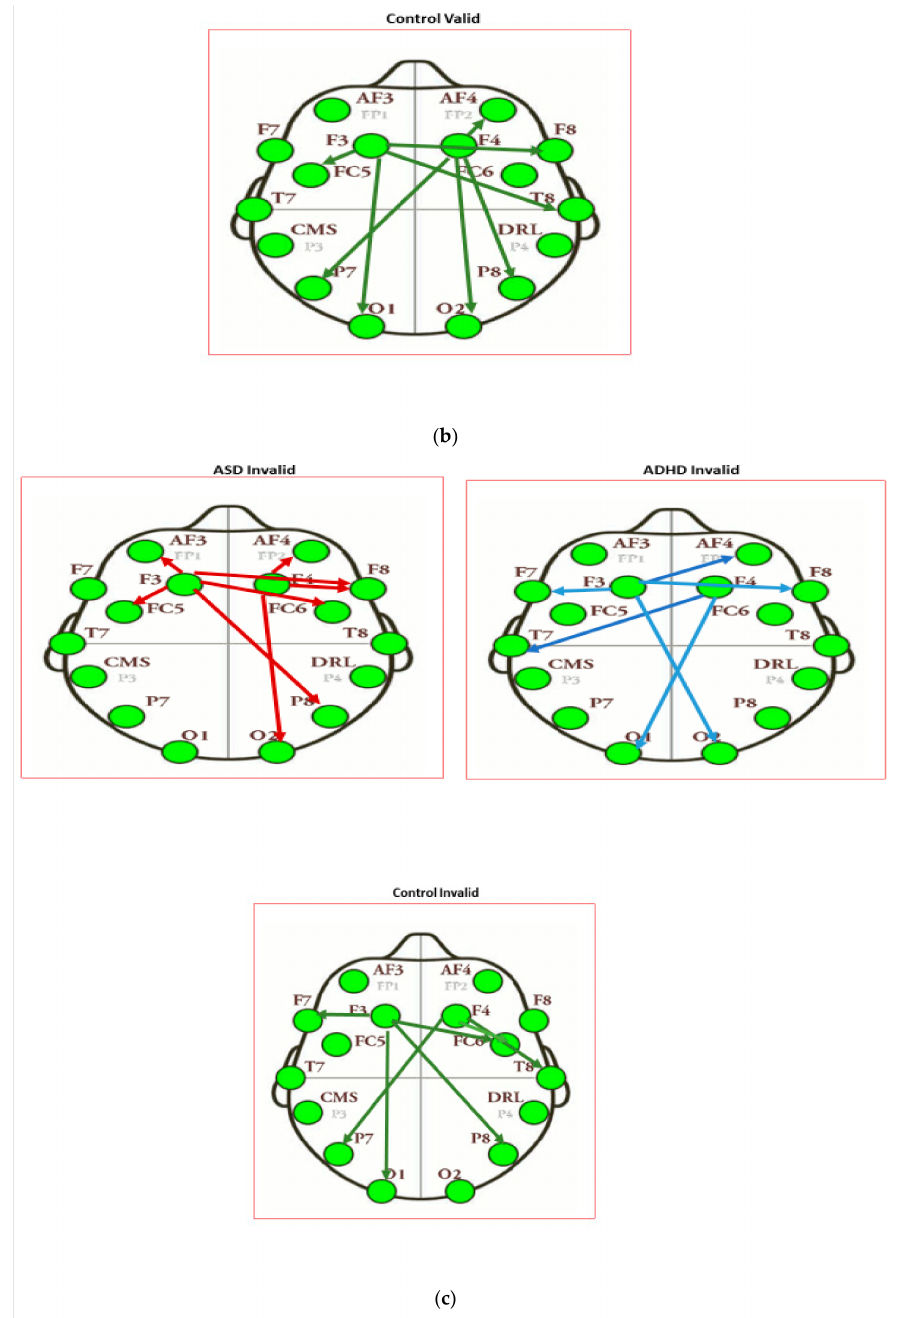
Figure 31. ( a ) The seven major brain functional networks (from Raichle M., 2001, freely available in ftp://imaging.wustl. edu/pub/raichlab/restless_brain, accessed on 8 November 2021) [148], used in this work to correspond our activated regions, due to seeds F3 and F4, with regions of the above major brain networks. ( b ) Connectivity network generated via seed-PLSC approach, when using electrodes F3 and F4 as seeds, for the case of valid syllogism. Lines of different colors correspond to different groups of participants, indicating which other electrodes are activated during the valid syllogism. The seeds have been chosen as the brain regions involved in emotion regulation and goal-specific working memory during a cognitive task (here the valid syllogism), based on the literature review. The lines connecting the F3 and F4 seed